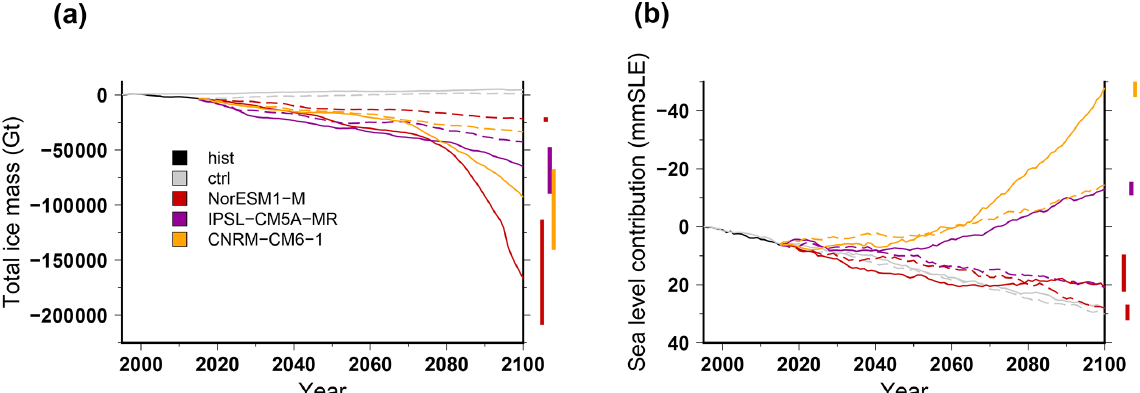
Figure 9. Simulated total ice mass change (a) and ice volume contributing to sea level rise (b) for projections using climate models run under a high-emission (solid lines; RCP8.5 for NorESM1-M and IPSL-CM5A-MR and SSP585 for CNRM-CM6-1) and a low-emission (dashed lines; RCP2.6 for NorESM1-M and IPSL-CM5A-MR and SSP126 for CNRM-CM6-1) scenario for greenhouse gases with a medium oceanic sensitivity. The evolutions begin with the historical simulation hist (1995–2015), and the control experiments ctrl and ctrl_proj are depicted in grey (solid and dashed, respectively). For each projection experiment, the vertical bar shows the minimal and maximal changes associated with the oceanic-forcing sensitivity to temperature change ( low and high